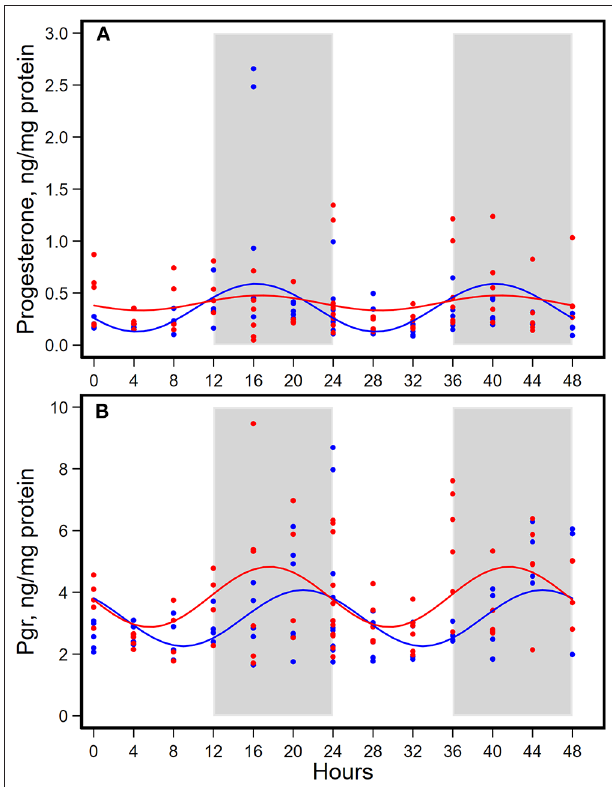
FIGURE 5 | Diurnal expressions of concentrations of progesterone (A) and progesterone receptor (Pgr, B ) in mammary glands from pubertal mice fed AIN93G or high-fat diet ( n = 5 per time point per group). Open background: light phase; gray background: dark phase; blue circles and line: AIN93G diet; red circles and line: high-fat diet. The rhythm curves were generated by using the Cosinor model y = mesor + amplitude x Cos [2 π /24 × (t—acrophase)].